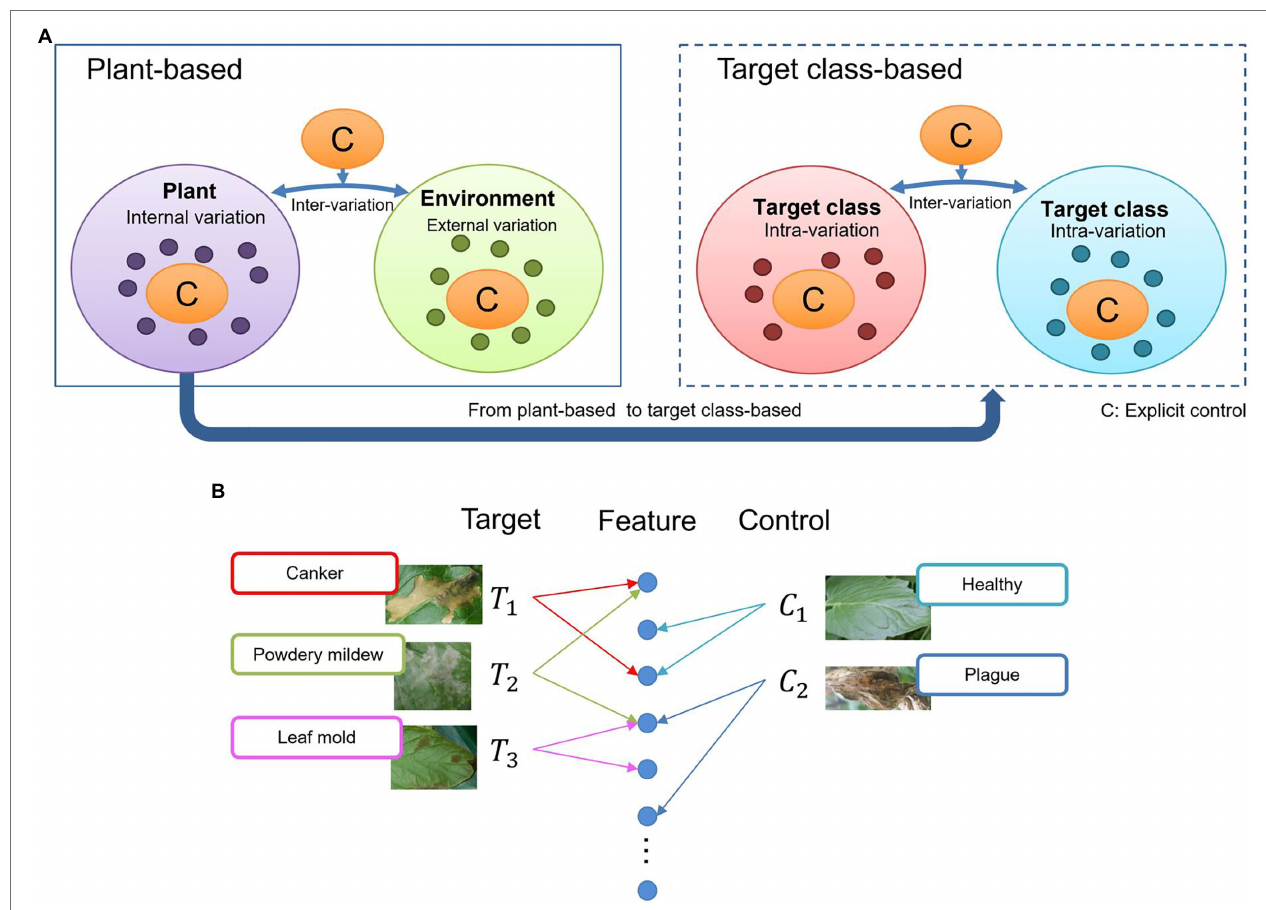
FIGURE 3 | General overview of the context of the problem addressed by our proposed approach. (A) Intra-and inter class variations at plant-based and target class-based models. An explicit control of these variations can make a deep learning model become more oriented to learning various types of features. (B) Feature association in the space and feature domains. Similarities between diseases can affect the final